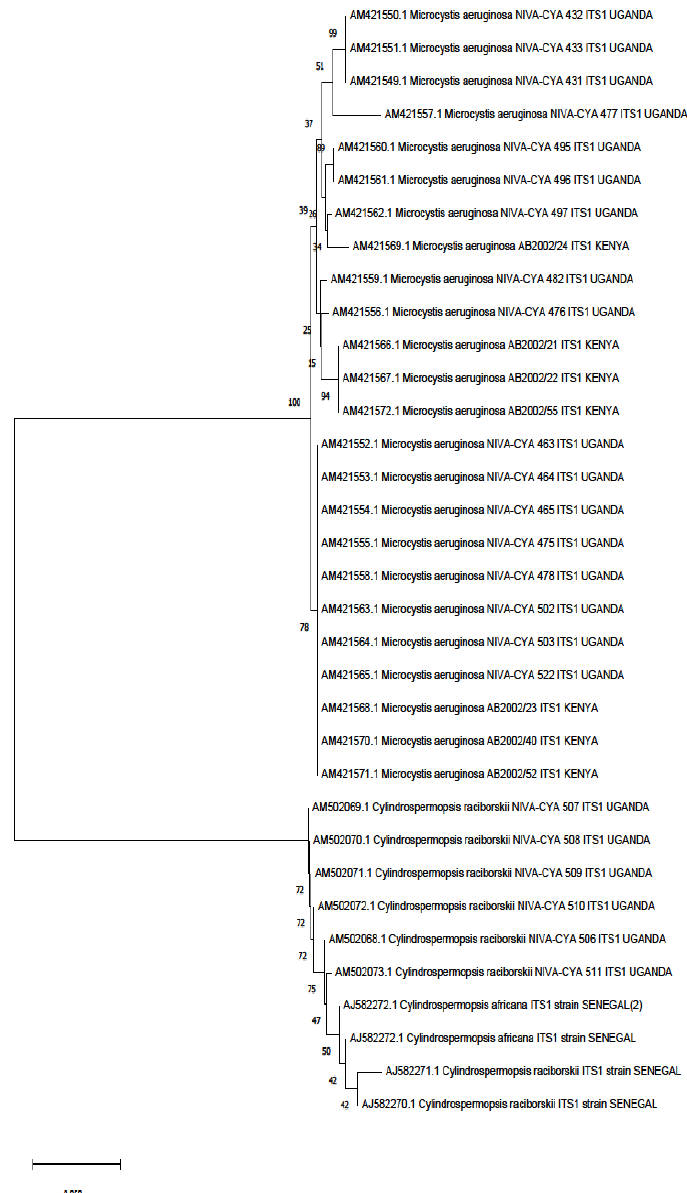
Figure 4. Phylogenetic tree constructed using the neighbor-joining method of the ITS1 sequences’ gene of cyanobacteria detected from studies on the continent. Branches corresponding to partitions reproduced in less than 50% of bootstrap replicates are collapsed. The percentage of replicate trees in which the associated taxa clustered together in the bootstrap test (1000 replicates) are shown next to the branches. The evolutionary distances were computed using the Kimura 2-parameter method and are in the units of the number of base substitutions per site. This analysis involved 34 nucleotide sequences. All ambiguous positions were removed for each sequence pair (pairwise deletion option). There was a total of 539 bp in the final dataset. Evolutionary analyses were conducted in MEGA X version 11.